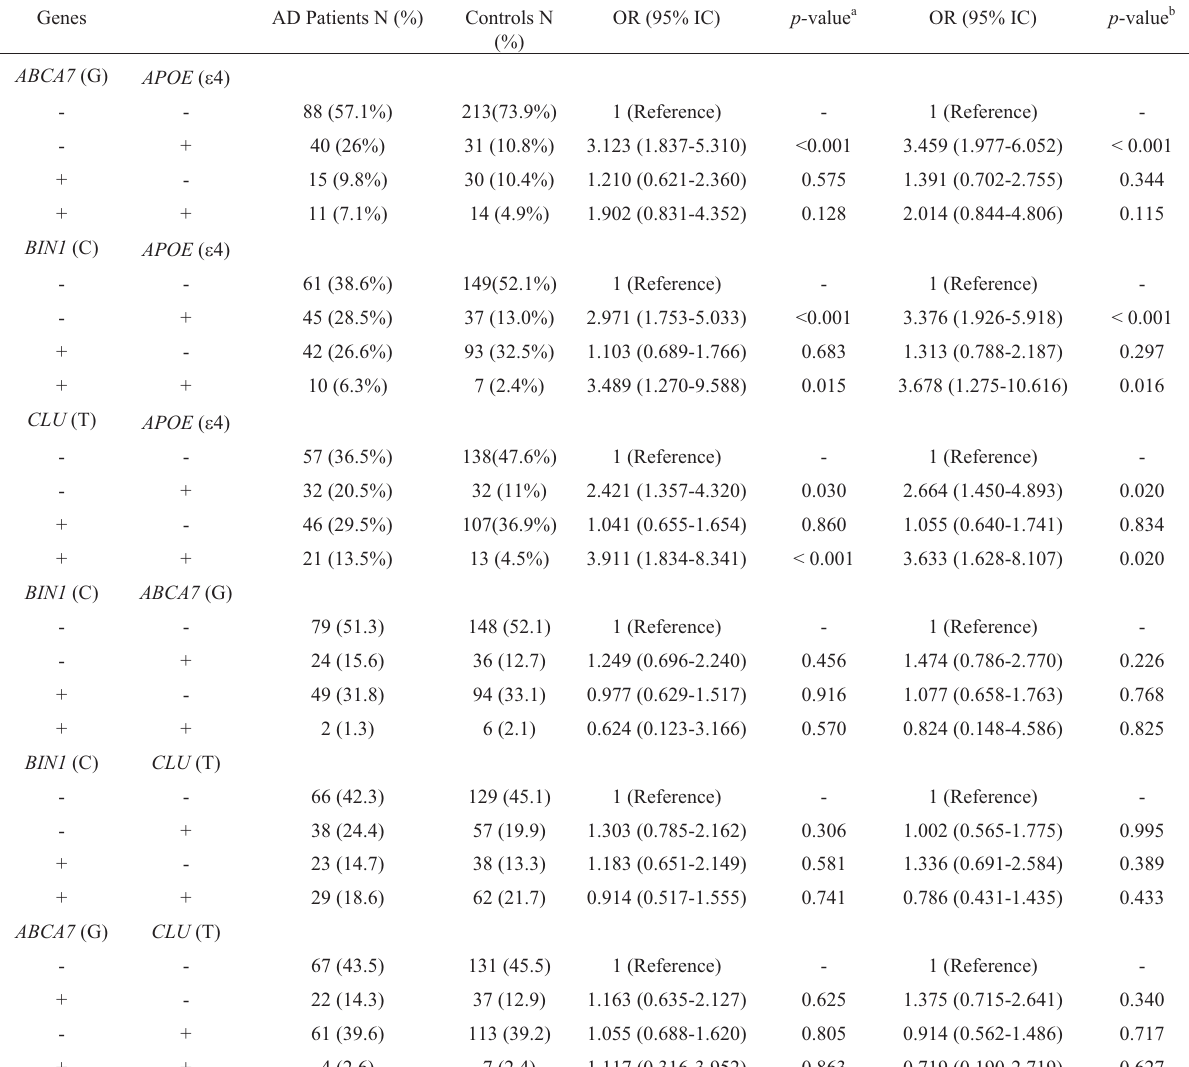
Table 3 - Combined allelic effect among variants in the study.